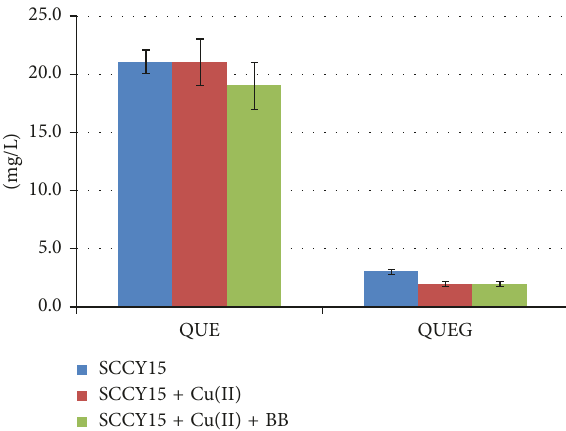
Figure 2: Contents of quercetin (QUE, mg/L) and quercetin glucoside (QUEG, mg/L) for SCCY15 wine samples before and after additions of Cu(II) and selected yeast derivatives (BB, Bˆatonnage body). Values (mean esd) obtained from three sam- ples and three replicates each sample. Each set of data (QUE and QUEG) was not statistically different (Tukey’s test). Full experi- ± mental data sets are reported in Table